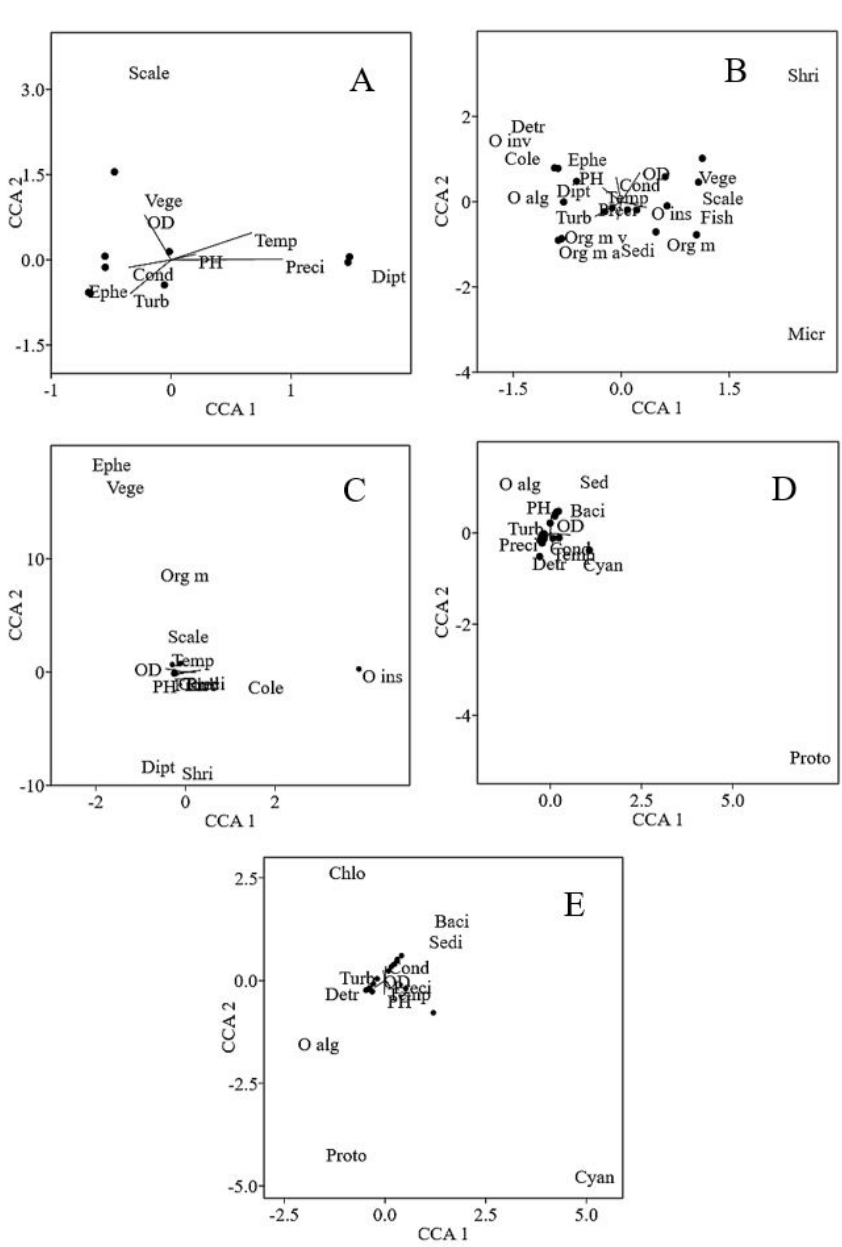
Figure 5. Canonical Correspondence Analysis (CCA) between environmental variables (rainfall, temperature, pH, dissolved oxygen, conductivity and turbidity) and the Alimentary Index (IAI - per month collection) at the Estação Ecológica do Seridó (ESEC-Seridó), Serra Negra, Rio Grande do Norte, Brazil. A – Astyanax bimaculatus Linnaeus,1758; B – Leporinus piau Fowler,1941; C – Hoplias gr. malabaricus Bloch,1794; D – Hypostomus cf. paparie Fowler,1941; E – Prochilodus brevis